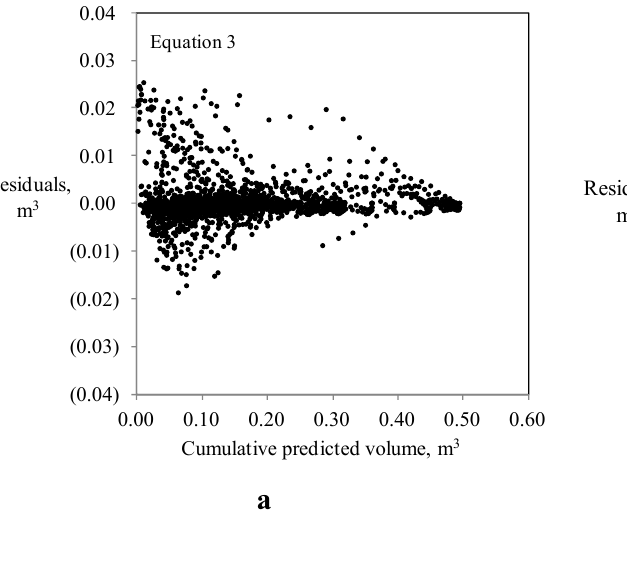
Figure 4. Residuals for the merchantable volume Equations (3) ( a ) and (4) ( b ) for Norway